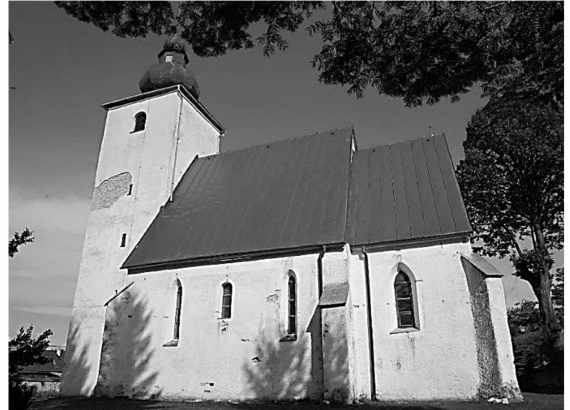
Figure 1. South view of the Roman Catholic Church: tower, nave and sanctuary.